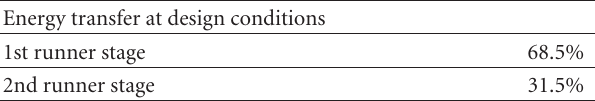
Table 3: Percentages of energy transferred in the 1st and 2nd stage at design conditions.